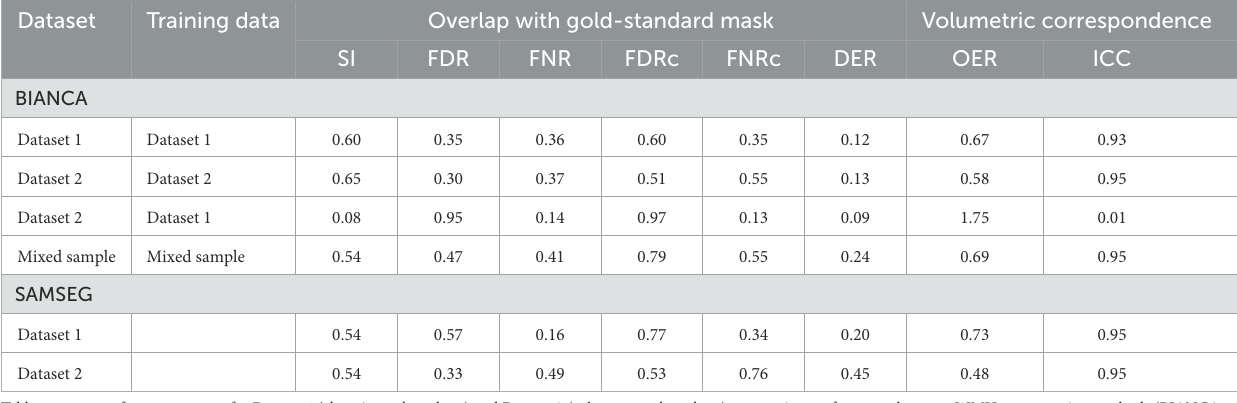
TABLE 2 WMH segmentation performance scores.